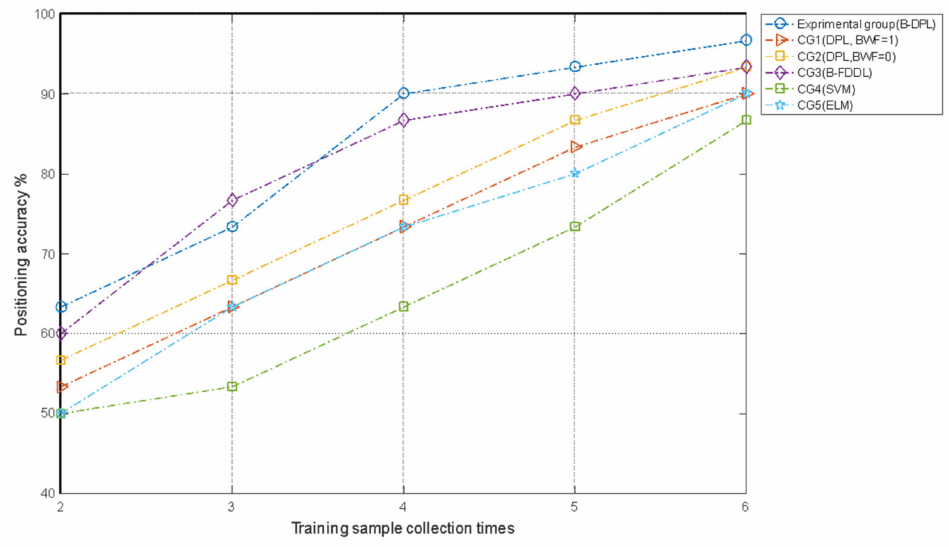
Figure 13. Positioning accuracy with different numbers of collections of training